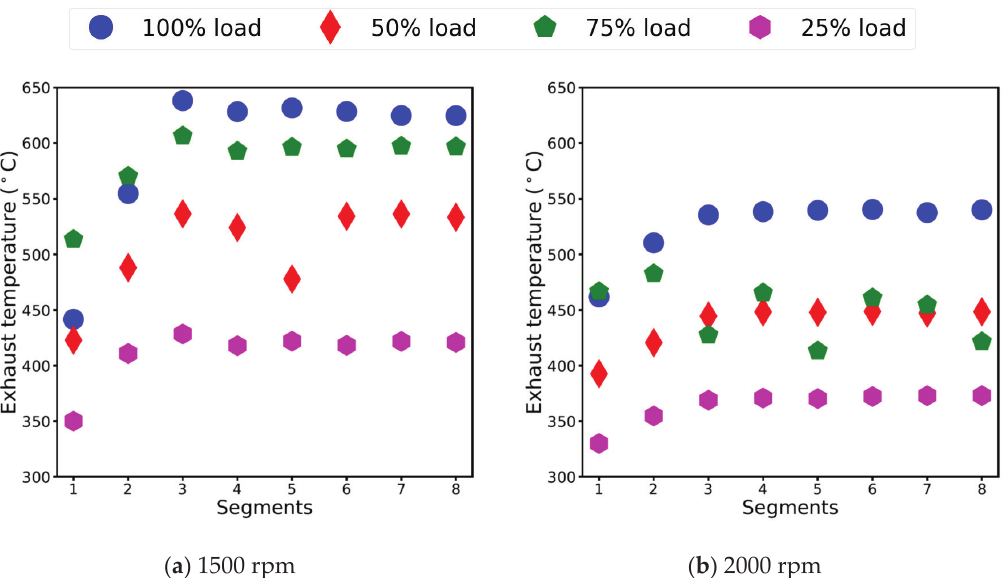
Figure 14. Average exhaust temperature at each load in each segment at ( a ) 1500 and ( b ) 2000 rpm. The blue circle represents 100% load, the red diamond 50% load, the green pentagon 75% load and the pink hexagon 25%